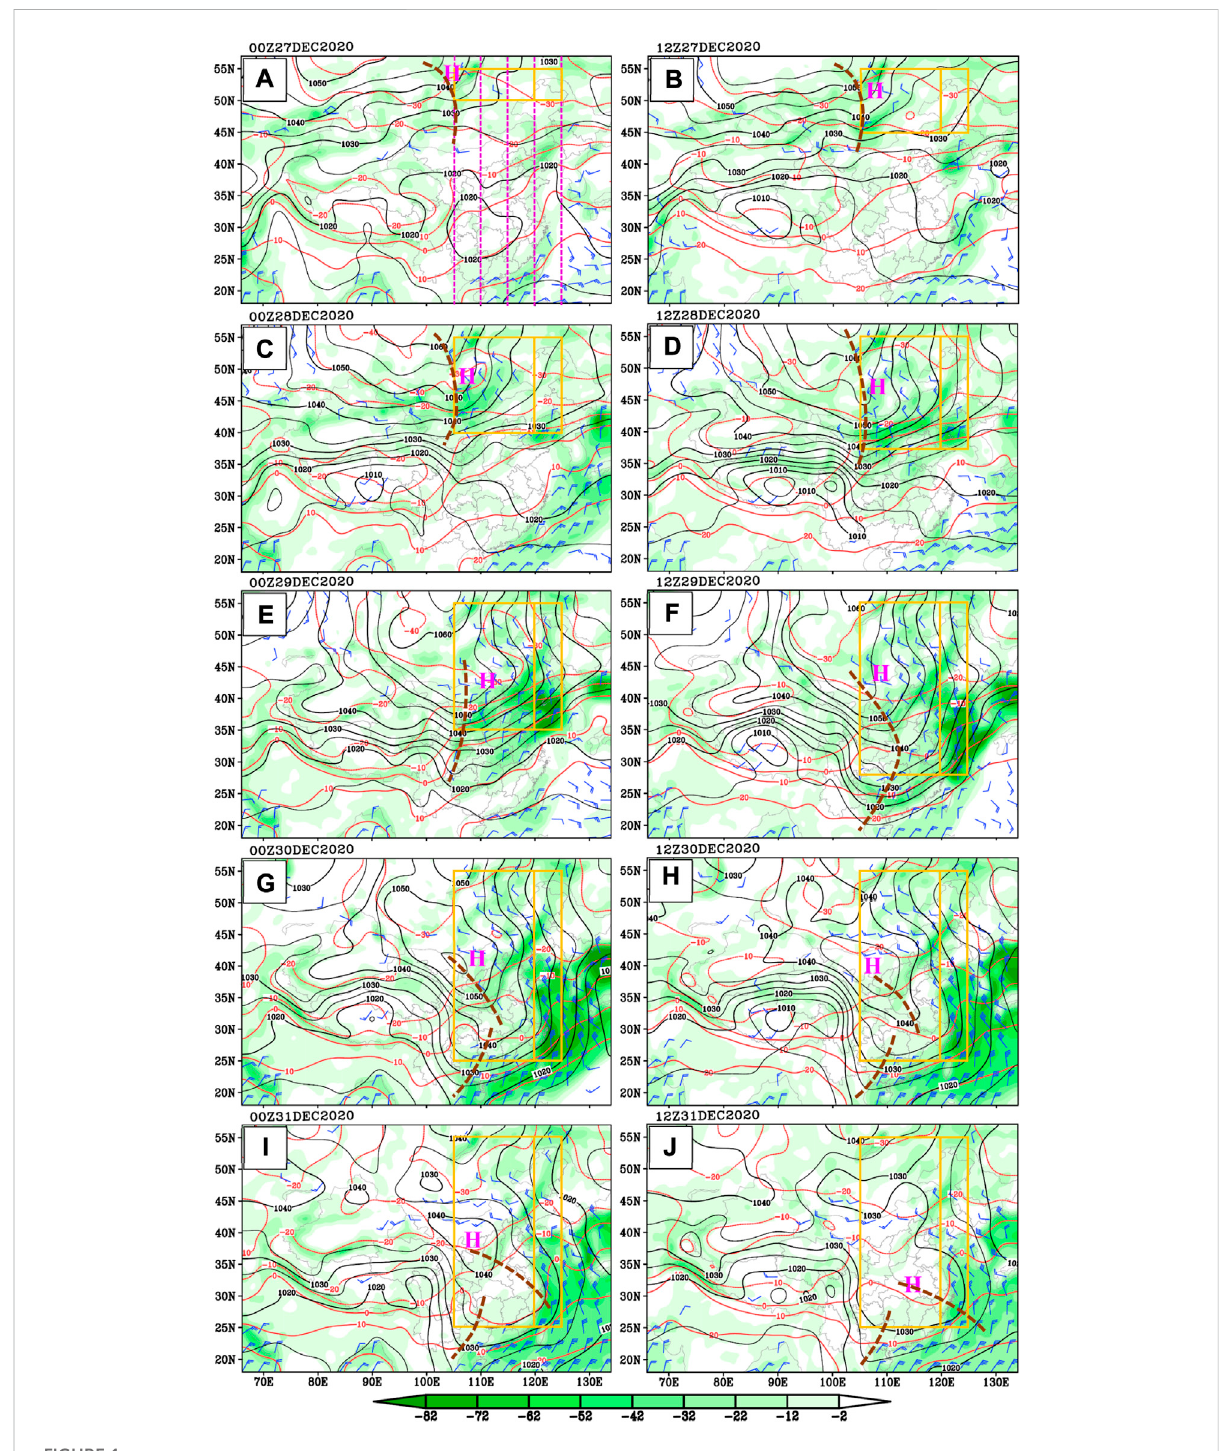
FIGURE 1 Temperature (red contours; ° C), temperature advection (shading; 10 − 5 K s − 1 ), and wind > 4 m s − 1 (full bar = 4 m s − 1 ) at surface and sea level pressures (black contours; hPa) ‘ H ’ = high ridge. Brown dashed lines = locations of ridge lines. Thin dashed purple lines = B1 and B2 notably affected by the cold wave event. Yellow boxes = FR1 and FR2 of the cold wave